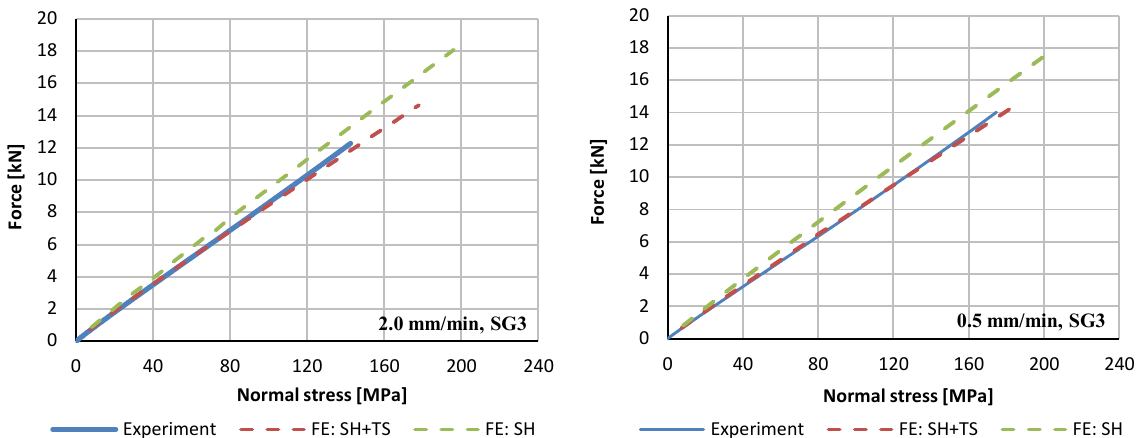
Fig. 14 Comparison of experimental and numerical tensile stress by SG3 of representative panel in displacement controlled test.